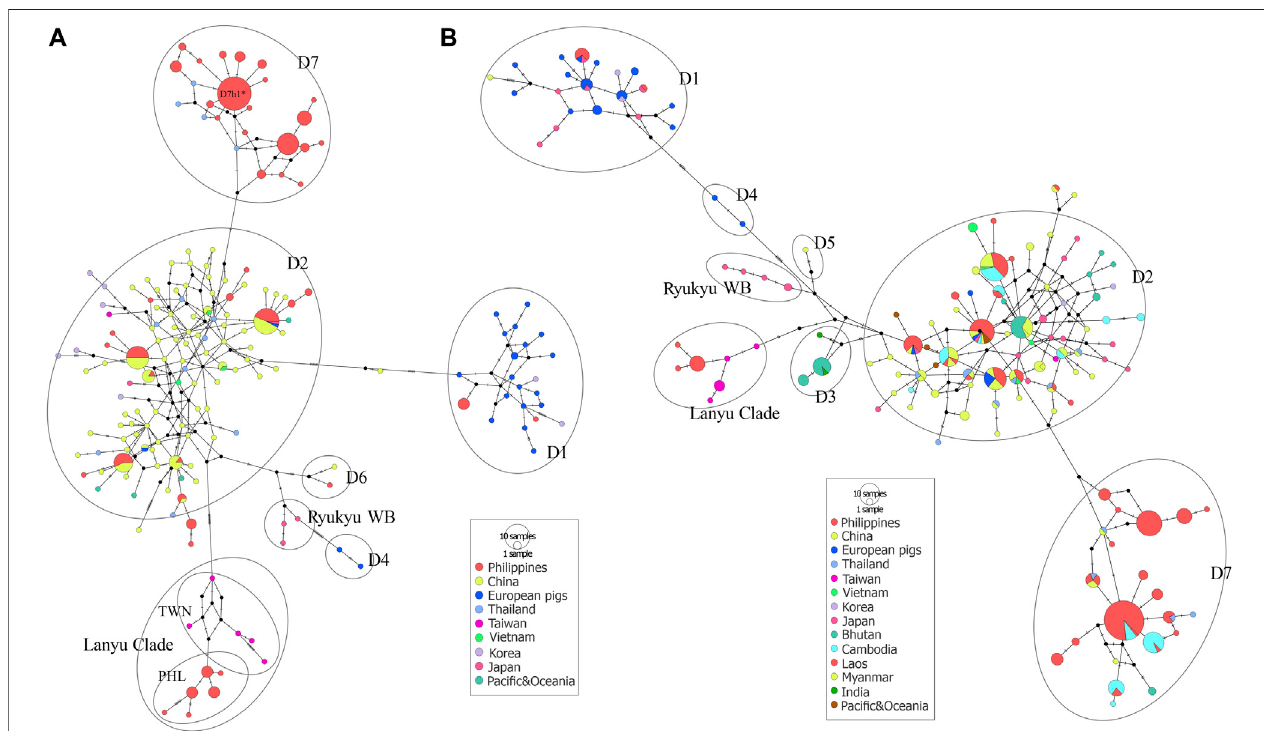
FIGURE 5 | Median-joining network of Philippine pigs (A) with global reference sequences of Asian and European pig haplotypes based on complete mtDNA D-loop sequences and a partial MJ network (B) using 510 bp to accommodate the major representative haplotypes through the partial mtDNA resolution used in the previous studies for a thorough haplotype representation of the different geographical locations. The size of each circle is proportional to the haplotype frequency. The color represents the regions from which the sequence originated.